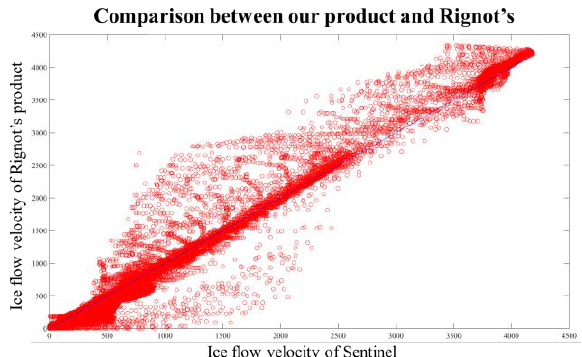
Figure 3 . Comparison of ice flow velocity: SAR product of this study (a) and Rignot’s product from MEaSUREs InSAR-Based Antarctica Ice Velocity Map (Mouginot et al., 2017) (b).